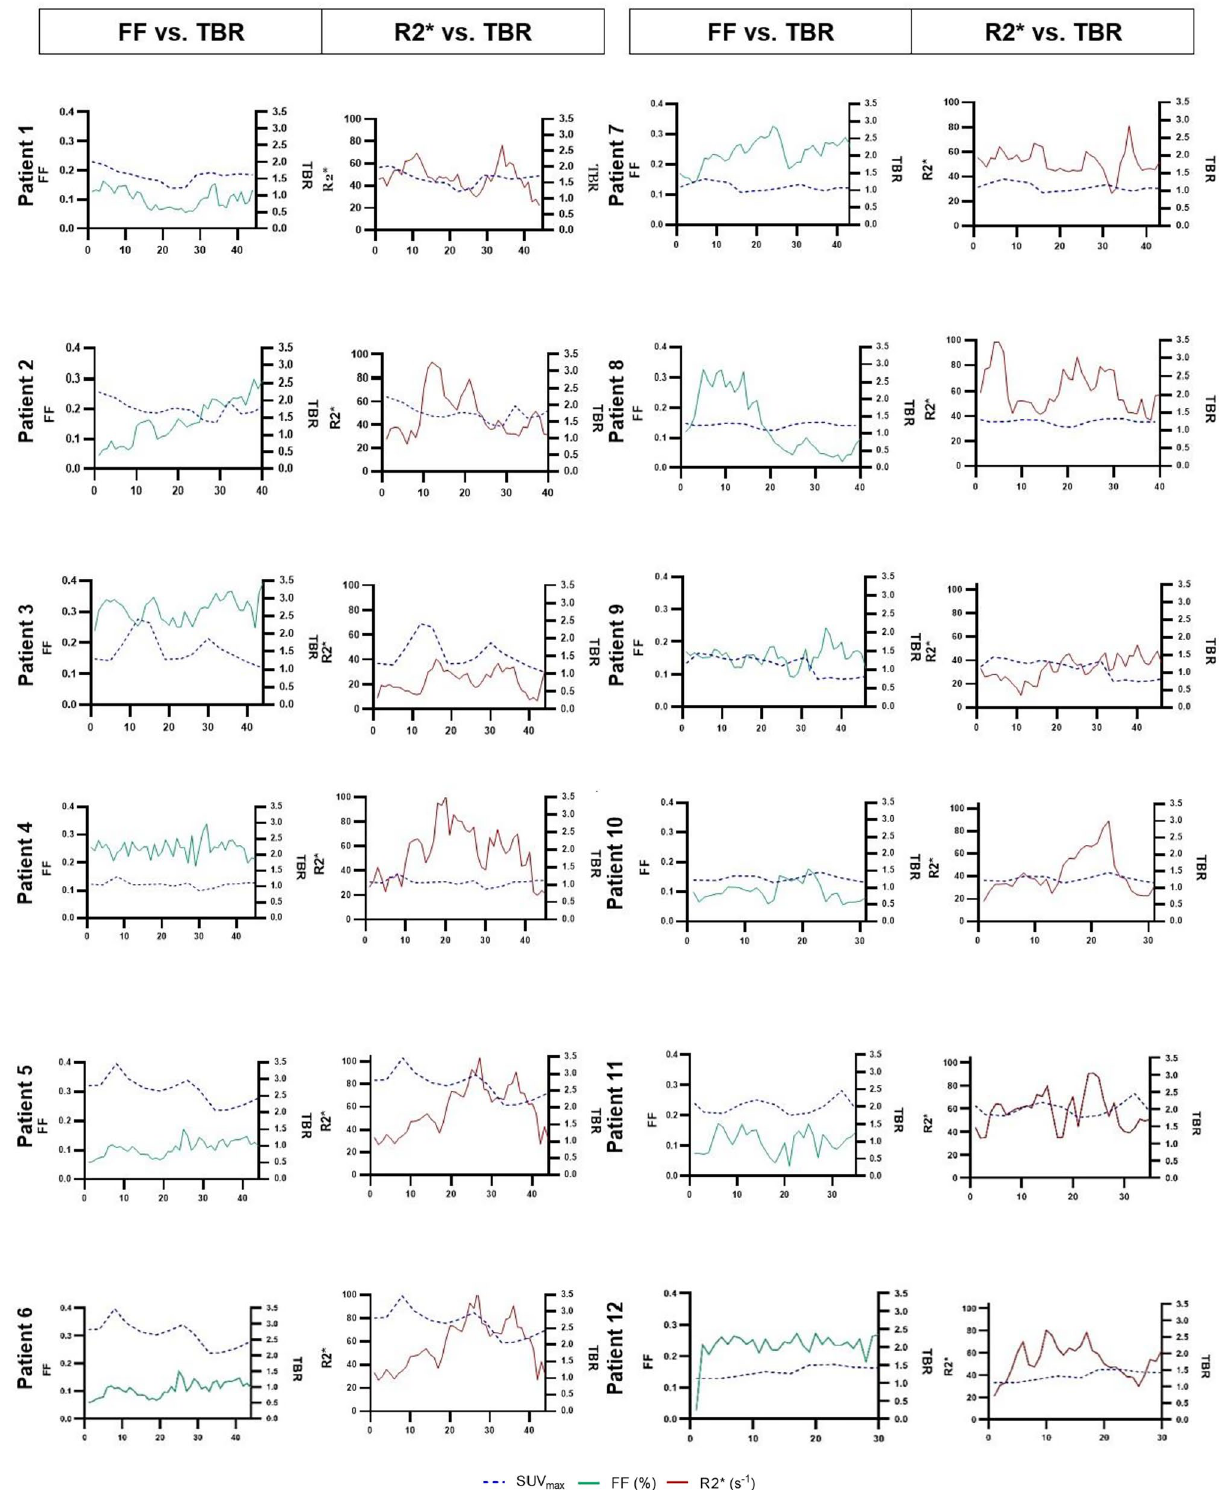
Figure 4. Slice by slice comparison throughout the plaques of target-to-blood pool ratio versus fat fraction and intraplaque hemorrhage. The left panels in the columns show FF and TBR per MRI slice, the right panels R2* and TBR per MRI slice. TBR values are shown on the right y-axis in the figures. The slice numbers are shown on the x- axis, slice numbers differ, as plaque length varies between the patients. The comparison of the 12 patients shows a large heterogeneity in both FF and R2* dispersion and no significant correlation between FF and TBR and respectively R2* and TBR. All graphs were created using GraphPad Prism version 9.0.0 for Windows, GraphPad Software, San Diego, California USA, www. graph pad. com. FF fat fraction, TBR target-to-blood pool